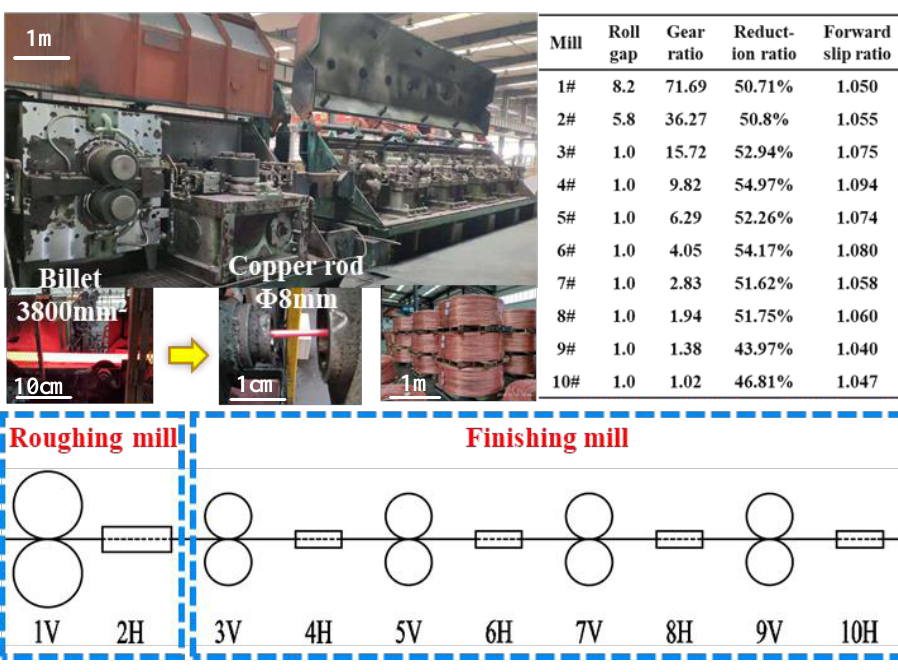
Figure 1. Schematic diagram of copper rod hot continuous rolling. Table 1. Actual Realized Conditions of Deformation in the Process of Rolling of Copper Wire Rods of 8 mm Diameter. Group